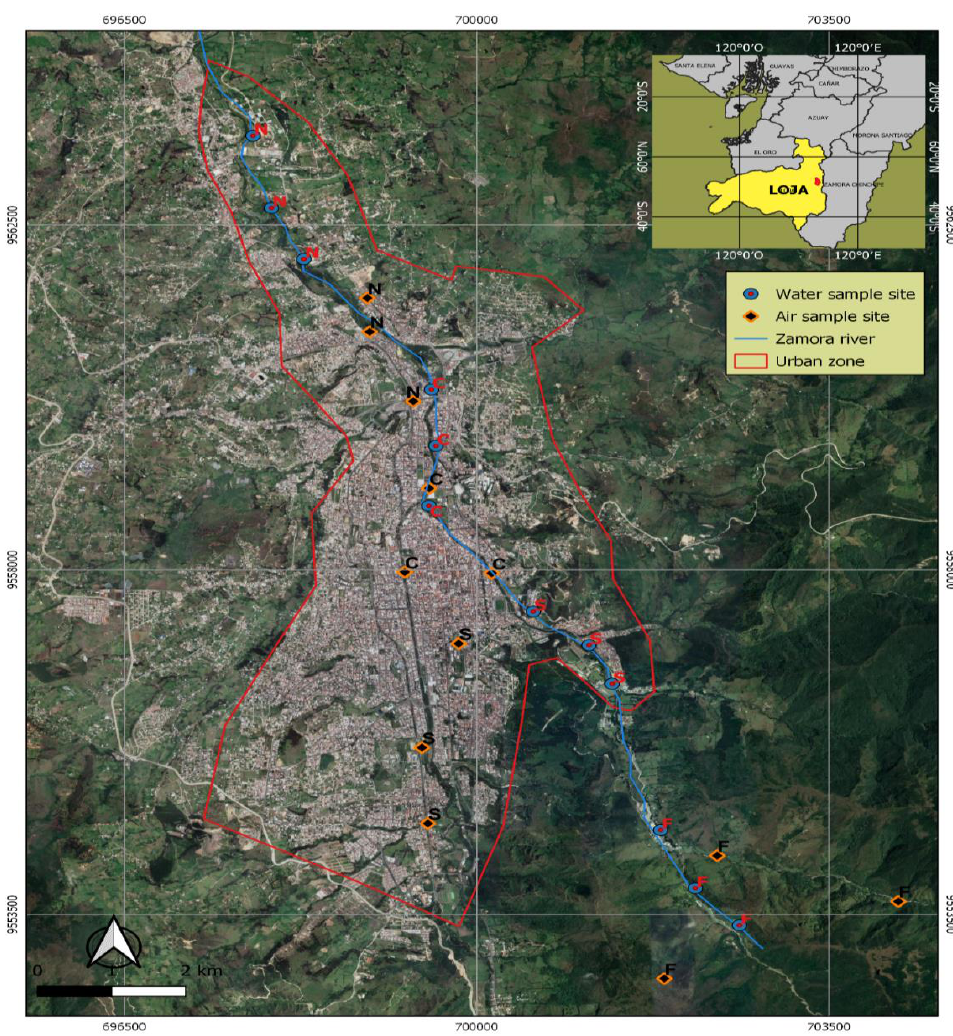
Figure 1. Map of the study area with sampling sites in the city of Loja. The red polygon shown urban zone of the city of Loja.